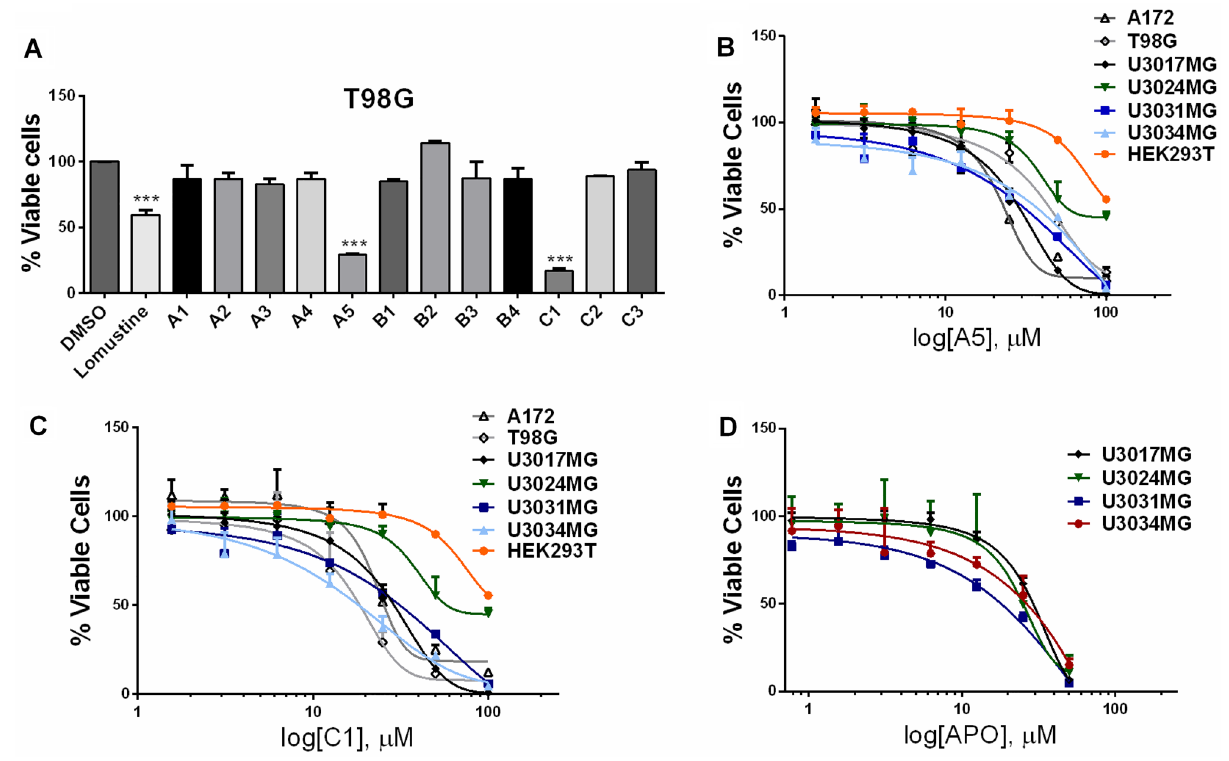
Figure 1. Assessment of cell viability in GBM cells. ( A ) Viability level of T98G cells after treatment for 48 h with 100 µM of selected substances tested in this study, as well as 12.5 µM of lomustine, used as a positive control for GBM cytotoxicity. Data were normalized against DMSO. IC 50 values were determined after treatment for 48 h with increasing concentrations of A5 ( B ), C1 ( C ) or APO ( D ). Cell viability was determined using the PrestoBlue reagent. These assays were conducted in triplicate (with at least two biological replicates); error bars represent mean ± SD. Asterisks denote significance as determined by one-way ANOVA multiple comparisons followed by Dunnet test (post-test); *** p <